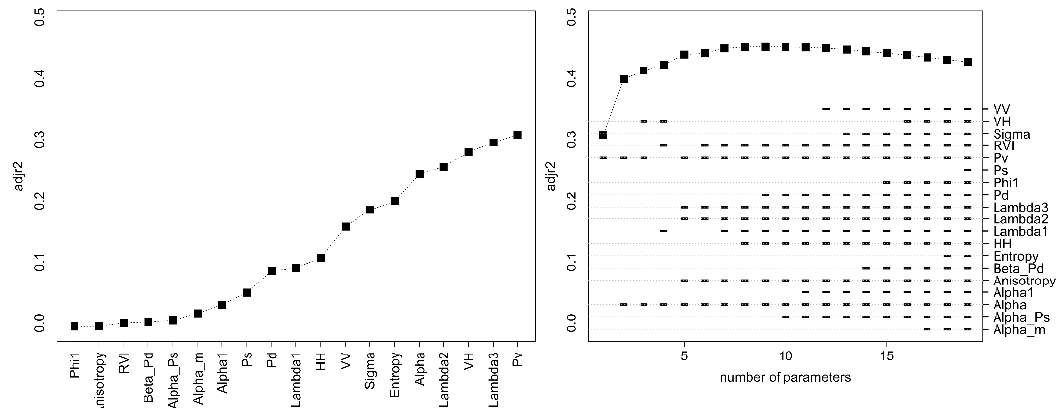
Figure 4. Exhaustive search results. The graph of the left shows all one-parameter models sorted by adjusted R 2 ; in the one on the right, the y-axis is the adjusted R 2 of the best models of size n (1 to 19) versus the number of parameters ( n ) on the x-axis. The right side vertical axis lists all parameters. A dash is included under each point (box) on the dotted line for a particular parameter if that parameter is included in the best model. For example, the best model of size n = 2 has an adjusted R-squared of around 0.43 and includes the parameters Pv and Alpha. Dashes also included the frequency a parameter occurs in one of the best models. Ps is the least used parameter and Alpha, and Pv are tied for most used parameters.